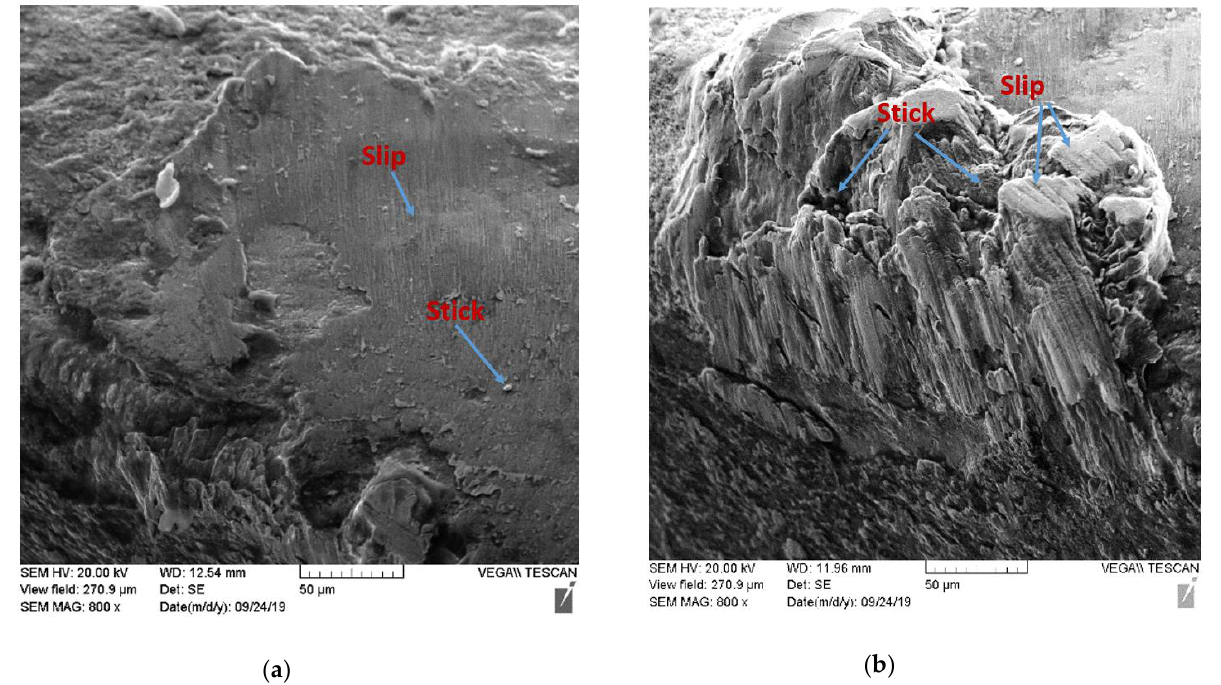
Figure 6. SEM images of the buildups: ( a ) low intensity (length of cut 800 m); ( b ) high intensity buildup (length of cut, 1000 m).